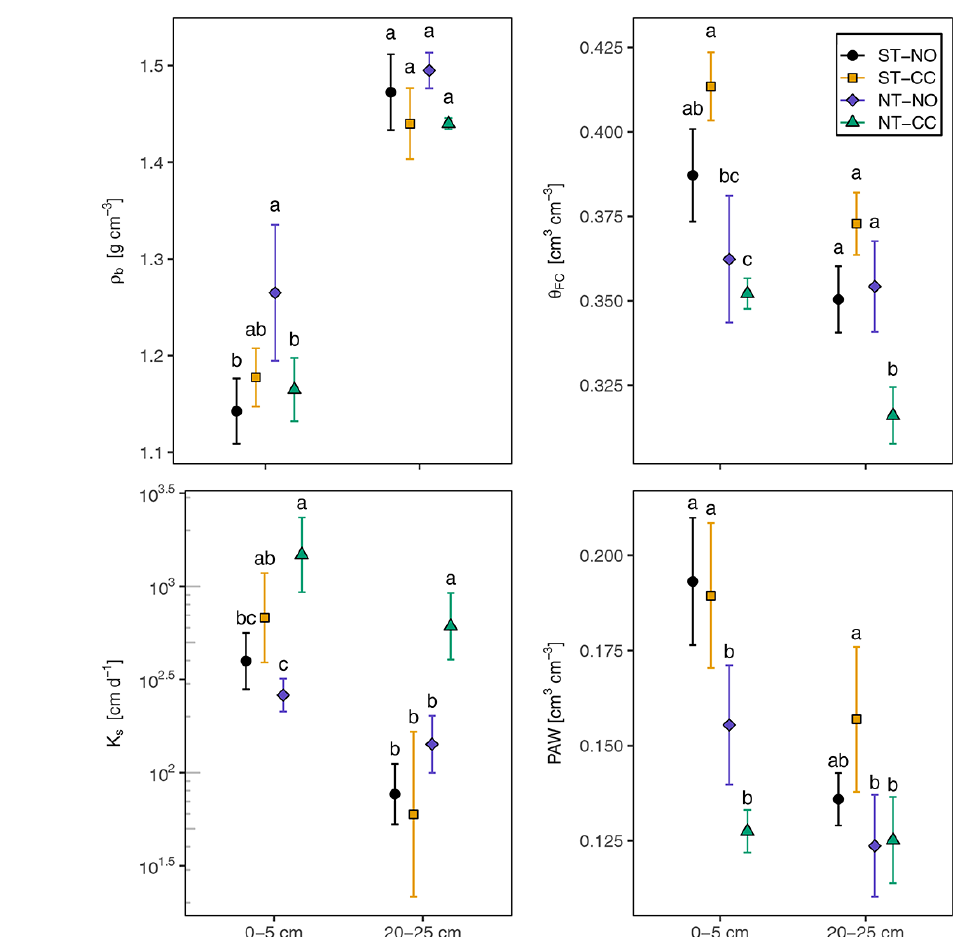
Figure 6. Mean bulk density ( ρ b ), saturated hydraulic conductivity ( K s ), water content at field capacity ( θ FC ), and plant-available water (PAW) of the top (0–5cm) and subsurface (20–25cm) layer soils. Bars indicate standard errors. Different letters within the same depth indicate differences at p < 0 . 15.